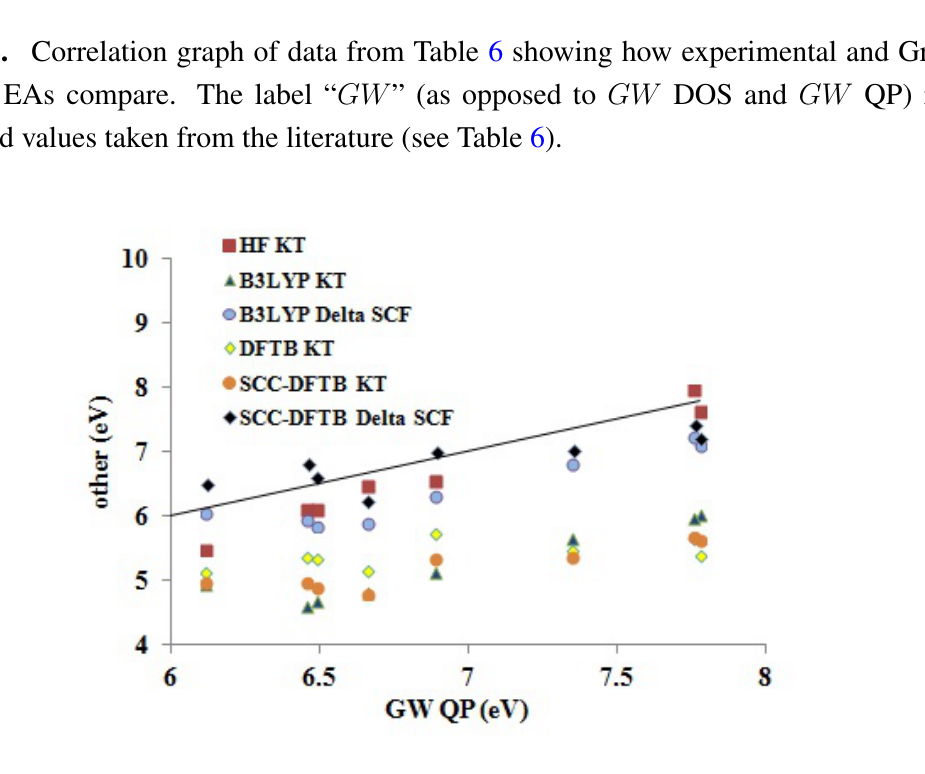
Figure 9. Correlation graph of data from Table 5 showing how the DFTB, SCC-DFTB and other methods compare to GW QP